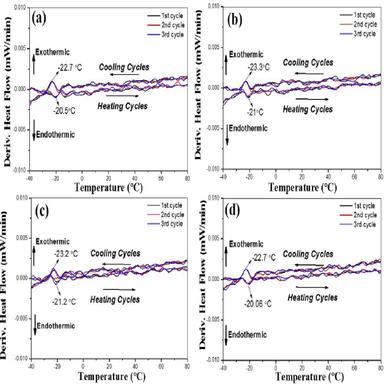
The DSC curves of the as deposited (a) FVO (b) Ti-FVO (c) W-FVO (d) Mo-FVO thin films deposited on the Al6061 substrates, as a function of temperature (Insets: The arrow marks identify the phase transition temperatures in the respective cases in correspondence).